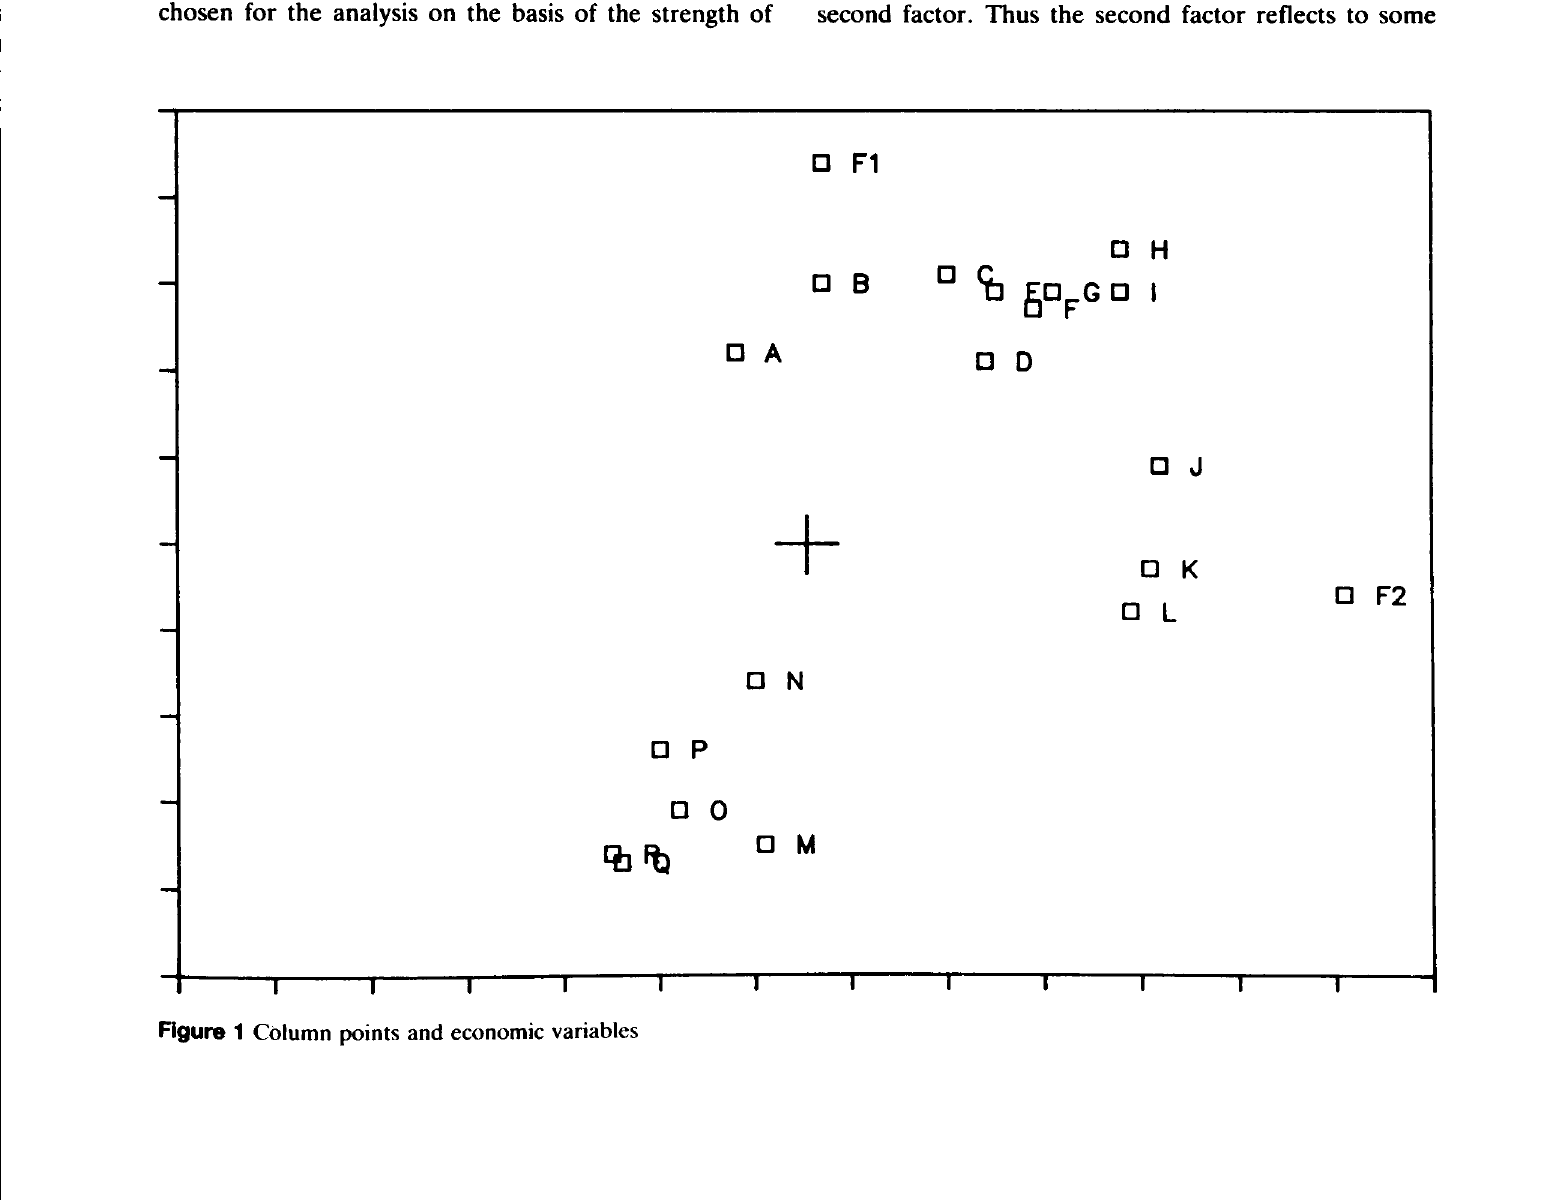
Figure 1 Column points and economic